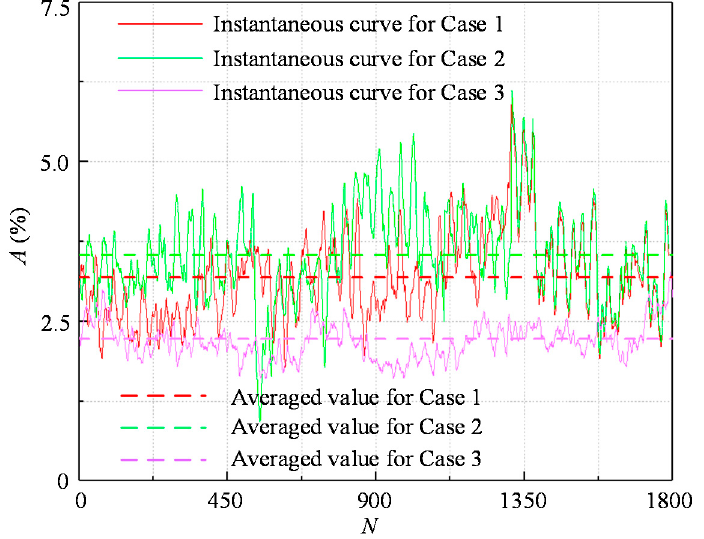
Figure 13. Vortex area evolution in the pump intake of the underground pumping Figure 13 . Vortex area evolution in the pump intake of the underground pumping station.